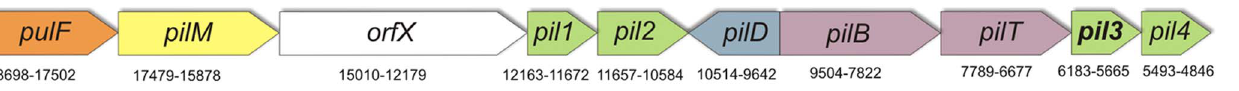
Figure 5. Type IV pili biogenesis cluster ofR.flavefaciens 007C. The protein Pil3, encoded by the pil3 gene, shares 51% amino acid identity to the cellulose-binding protein (CbpC) of R. albus 8 and 43% amino acid identity to R. albus 20 protein GP25 (a protein that was shown to be underproduced by spontaneous cellulose adhesion-defective mutant D5). The gene downstream ( pil4 ) encodes another protein with prepilin-type IV N-terminal domain, whereas the genes upstream encode: putative PilT 2 /PilB-like ATPases ( pilT, pilB ), prepilin peptidase ( pilD ), two proteins with pseudopilin PulG-like domains ( pil1 , pil2 ), type IV pilus assembly protein ( pilM ) and a type II secretion system protein ( pilF ). OrfX refers to open reading frame without recognized signal